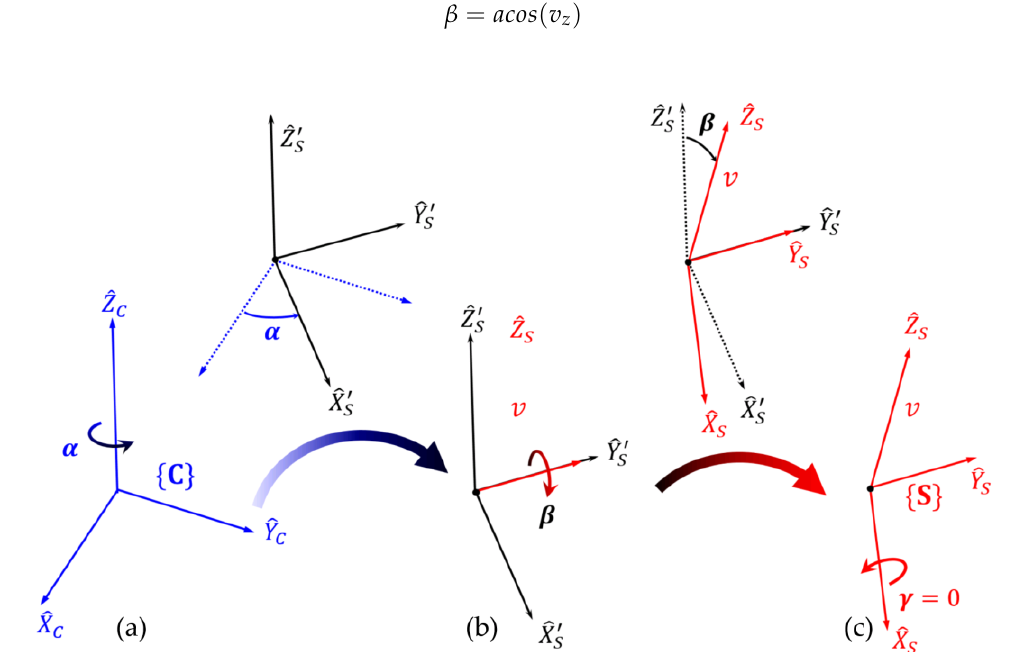
Figure 6. Z - Y - X Euler angles: ( a ) rotation around 𝑍̂ 𝐶 ; ( b ) rotation around 𝑌′̂ 𝑆 ; ( c ) rotation around 𝑋̂ 𝑆 .